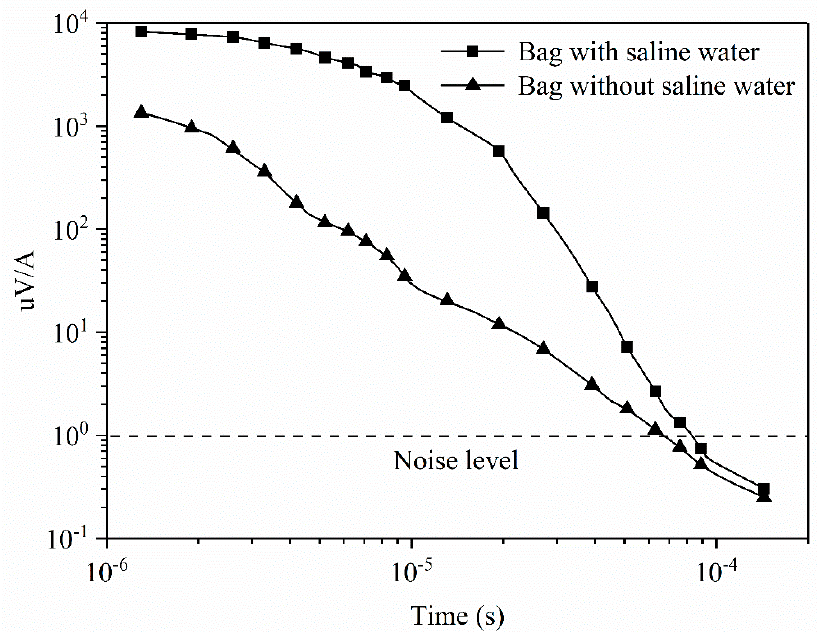
Figure 15. Normalized transient electromagnetic response results under the two conditions.